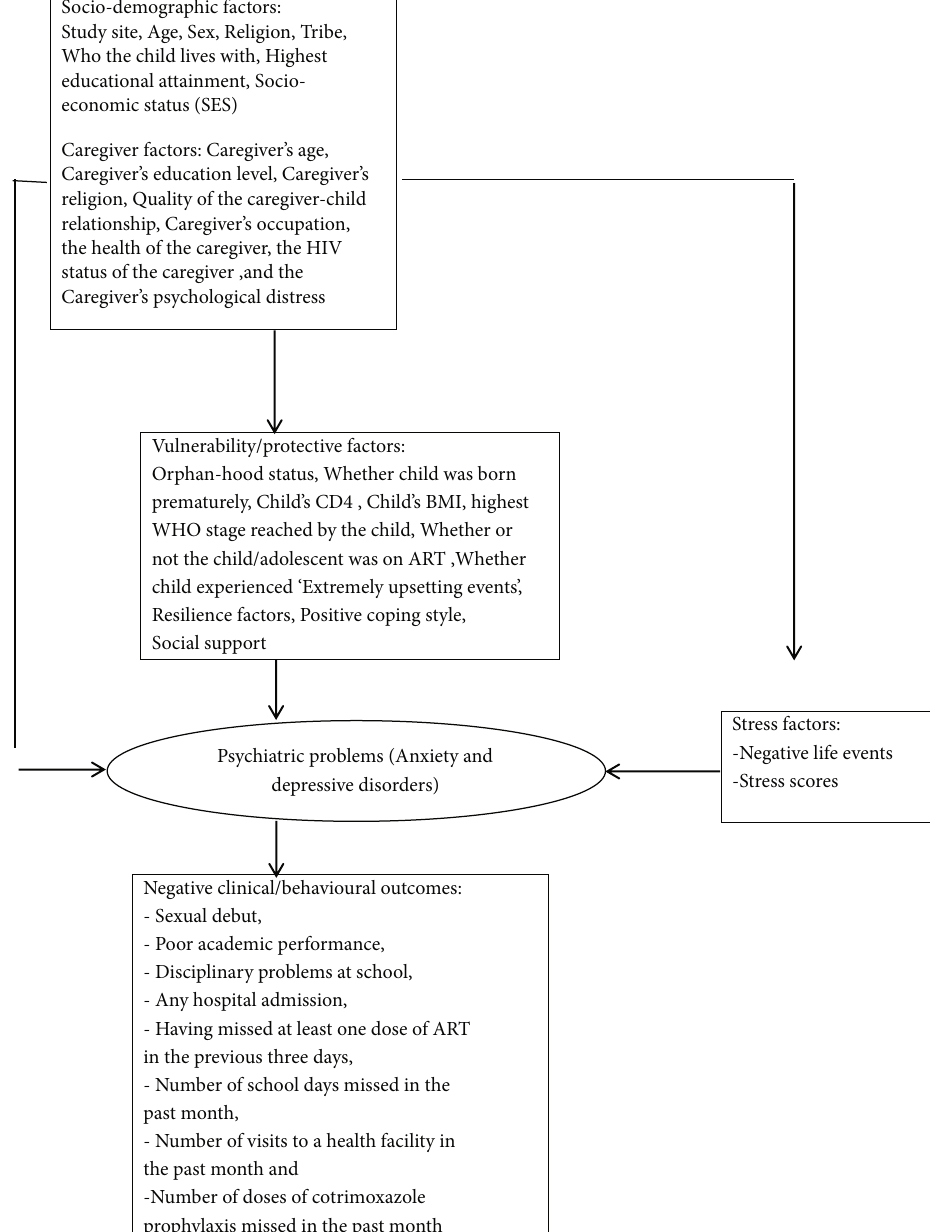
Figure 1: Conceptual framework based on the stress vulnerability models for anxiety and depressive disorders